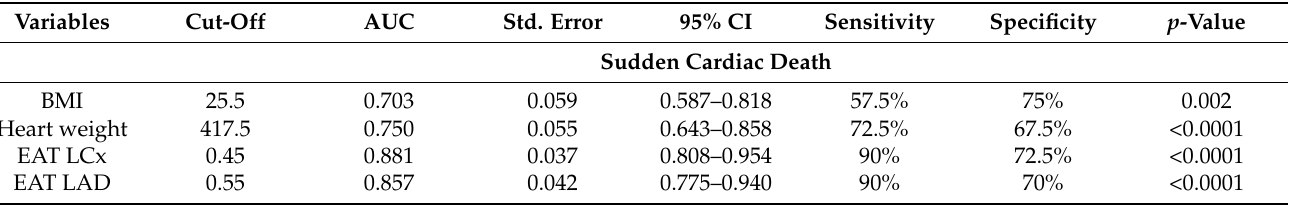
Table 2. The AUCs of the ROC curves, 95% confidence intervals, sensitivities, and specificities of the BMI, heart weight, EAT LCx, and EAT